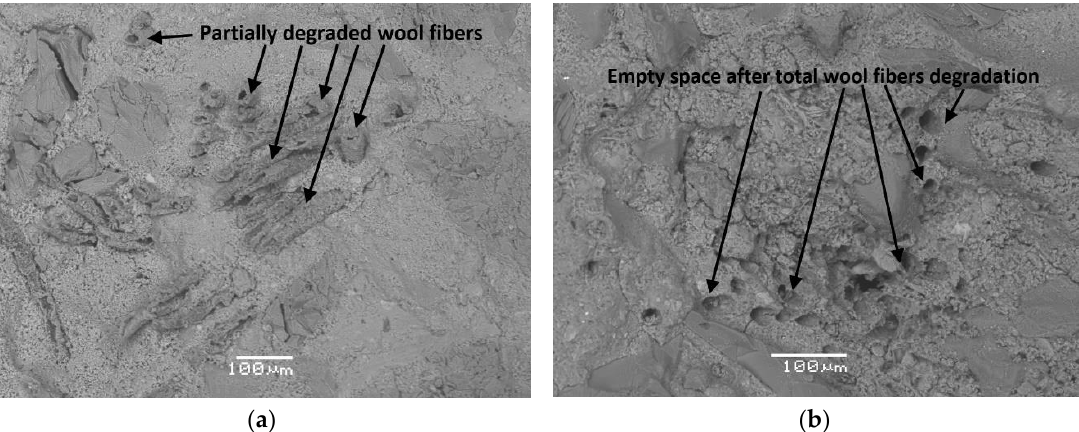
Figure 5. The microstructure of the mortar samples made with high-alkali cement and wool fibres addition cured at 20 °C: ( a ) 3 days and ( b ) 27 days, scale bar = 100 µm.